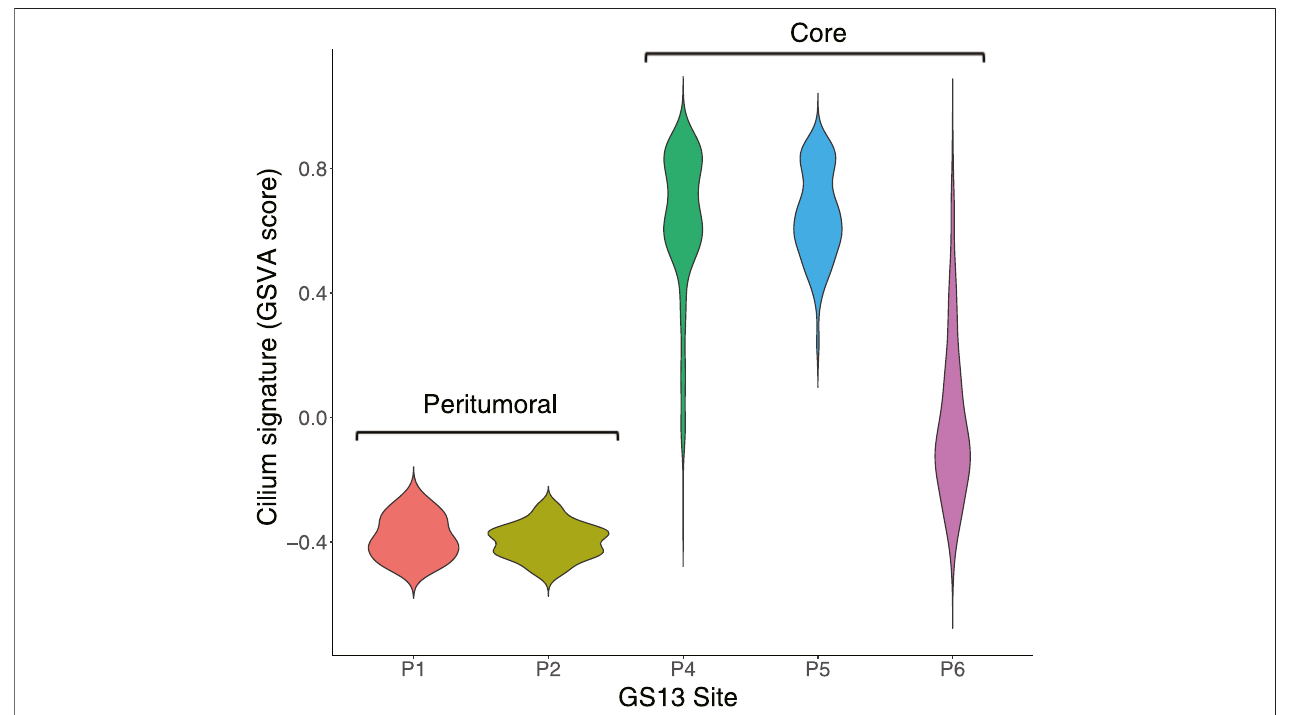
FIGURE5| DistributionofGSVAenrichmentscoresfortheciliumgene-setidenti fi edbyTuBAshowsasigni fi cantlyhigherexpressionincellsobtainedfromGS13 ’ s core tumor sites P4, P5, and